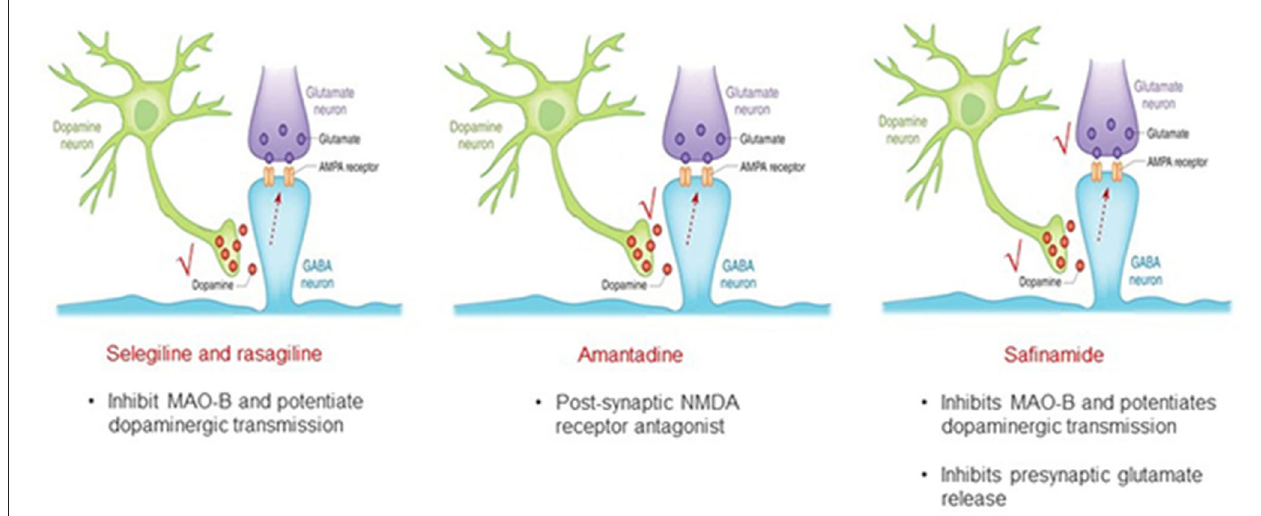
FIGURE 1 | Safinamide is a multi-modal drug with a double mechanism of action.